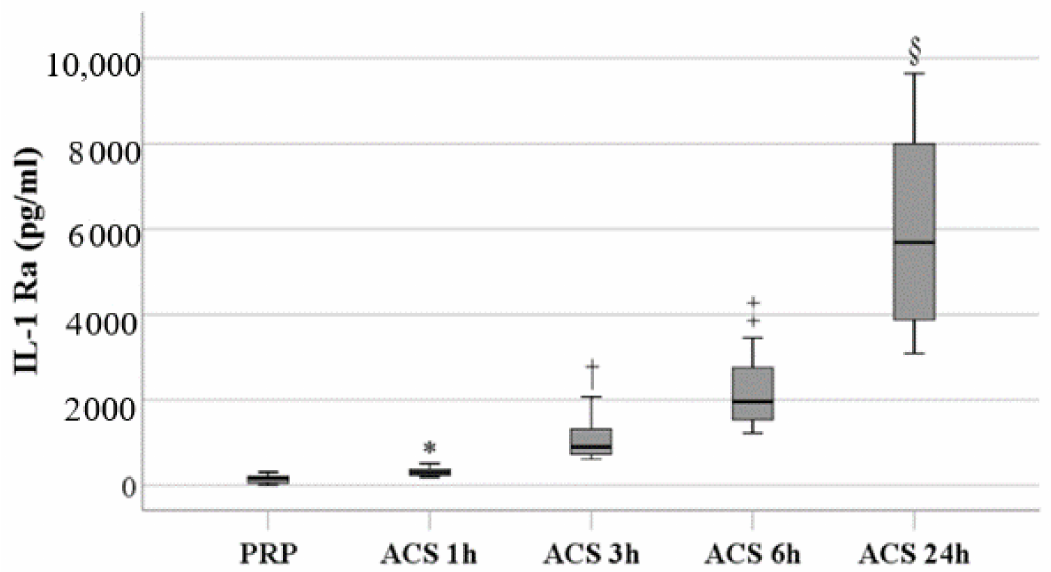
Figure 4. Interleukin-1 receptor antagonist (IL-1Ra) levels of platelet-rich plasma (PRP) and autolo- gous conditioned serum (ACS) with different incubation times. * indicates a significant difference as compared to PRP; † indicates a significant difference as compared to PRP and ACS 1 h; ‡ indicates a significant difference as compared to PRP, and ACS 1 h and 3 h; § indicates a significant difference as compared to PRP and ACS 1 h, 3 h, 6